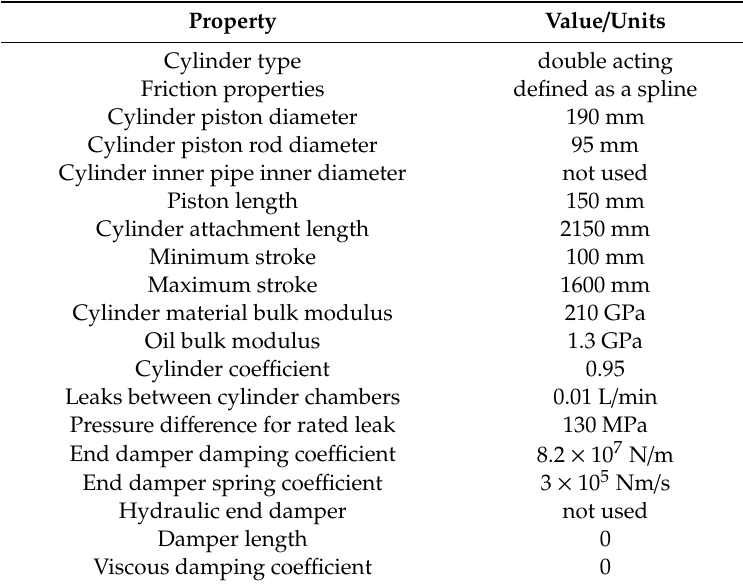
Table 1. Sample of stored properties for a hydraulic cylinder.